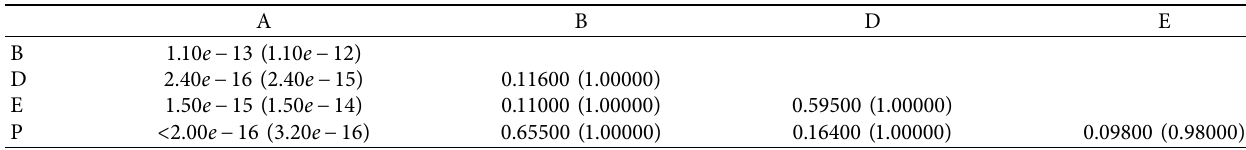
Table 14: In L-Space, for Linja-Karjala Oy network, pI � 0.05, pR � 0.0025, and T � 65, p -value of the Wilcoxon rank sum test (resultant p -value per Bonferroni correction is indicated in brackets).